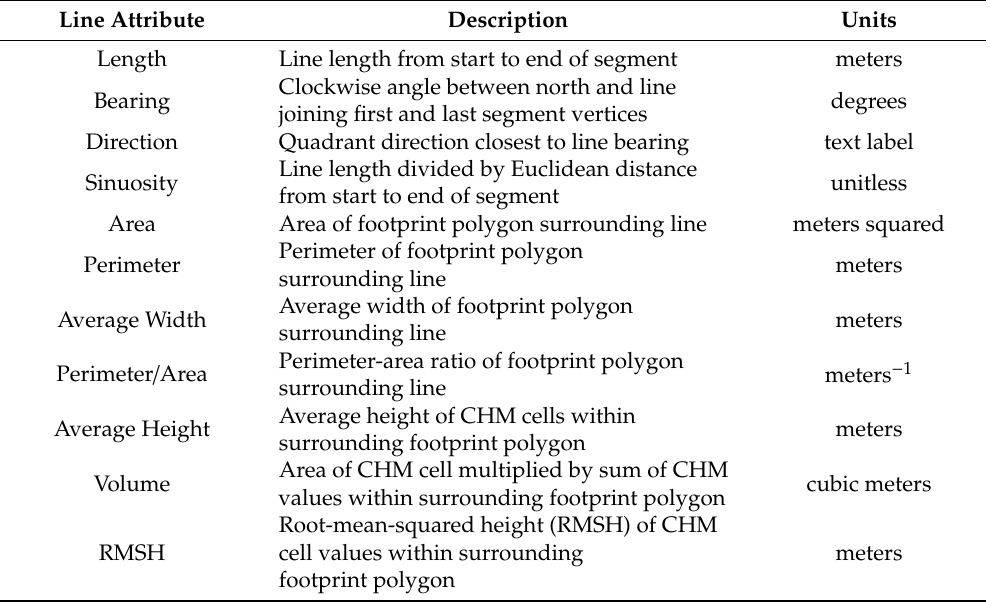
Table 1. Forest Line Mapper (FLM) attributes described with units of measurement. Each forest line mapped with FLM can receive these attributes. Some attributes are derived from polylines of the forest lines, some from footprint polygons surrounding the forest lines and some attributes are derived from canopy CHM cell values within those surrounding footprint